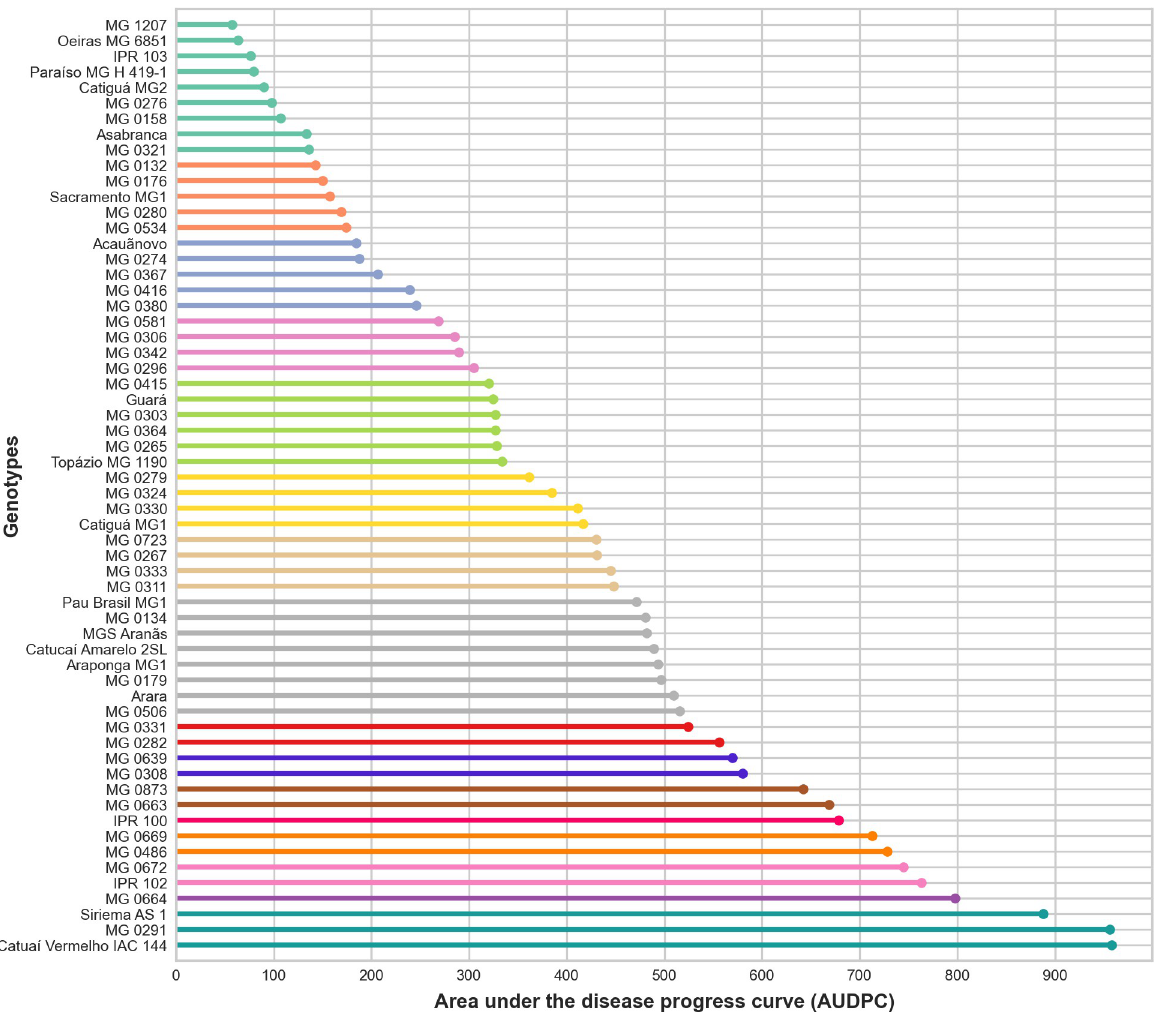
Fig 2. Area under disease progress curve (AUDPC). � Bars with the same color do not differ from each other by the Scott-Knott test (p � 0.05).